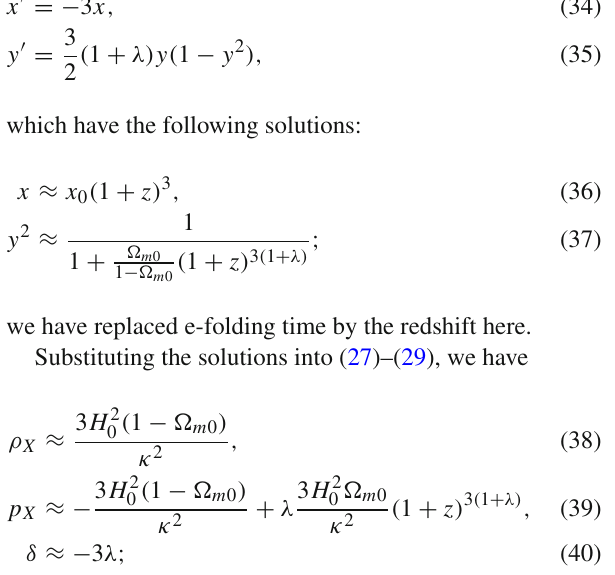
eigenvalues ( − 3 , − 3 ) are both negative. By rewriting the density and pressure in terms of the dimensionless